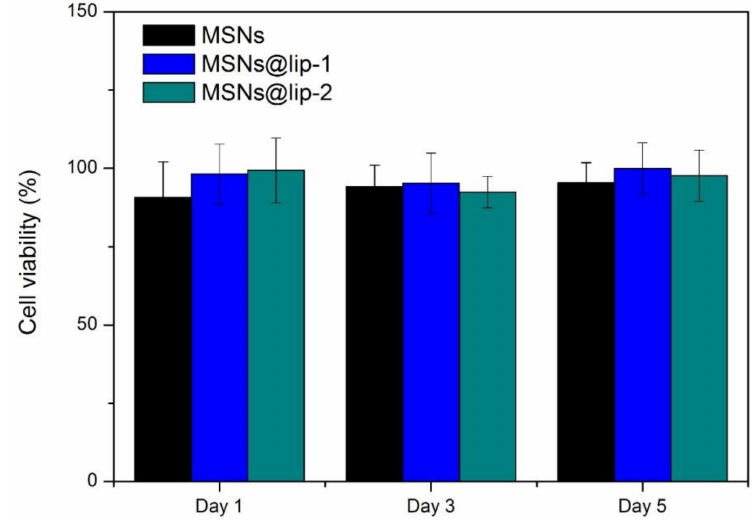
Figure 6. The relative MC3T3-E1 cell viability when incubated with MSNs, MSNs@lip-1 and MSNs@lip-2 for 1 day, 3 days and 5